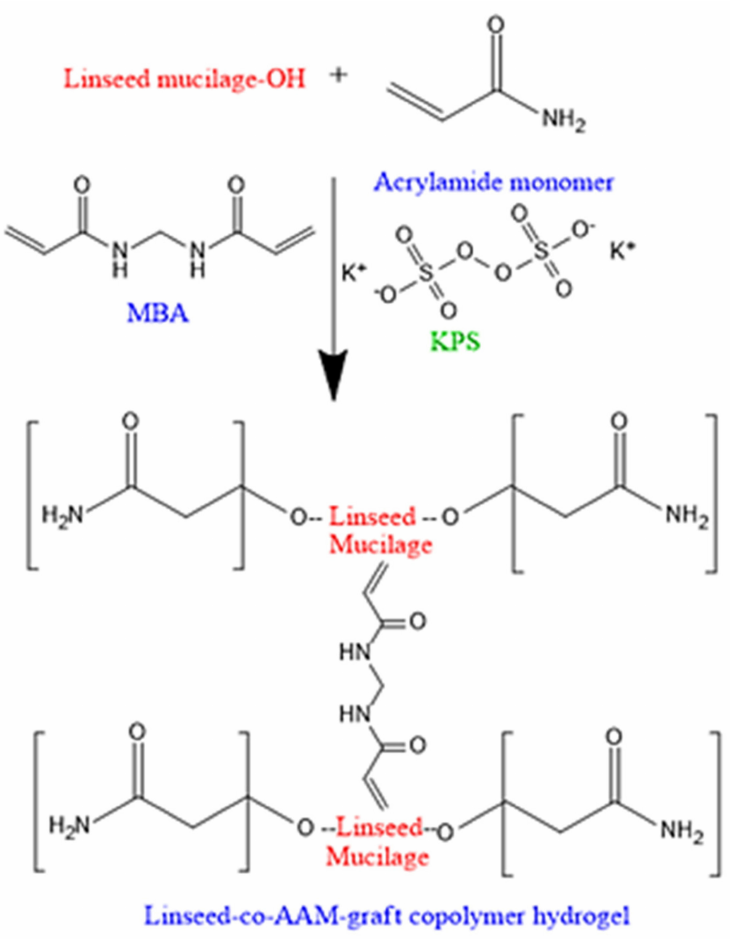
Figure 1. Schematic diagram for synthesis of linseed-co-AAM graft copolymeric hydrogels.